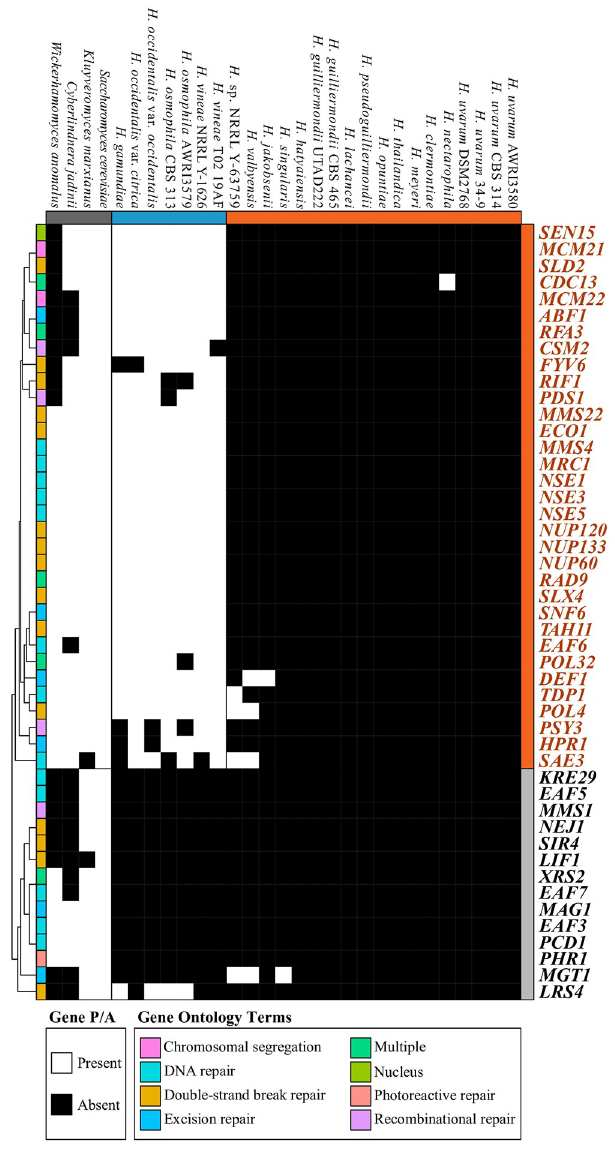
Fig 4. A panoply of genome-maintenance and DNA repair genes are absent among Hanseniaspora , especially in the FEL. Genes annotated as DNA repair genes according to GO (GO:0006281) and child terms were examined for presence and absence in at least two-thirds of each lineage, respectively (268 total genes). 47 genes are absent among the FEL species, and 14 genes are absent among the SEL. Presence and absence of genes was clustered using hierarchical clustering (cladogram on the left) where each gene’s ontology is provided as well. Genes with multiple gene annotations are denoted as such using the “multiple” term. figshare: https://doi.org/10.6084/m9.figshare.7670756. v2. ABF1 , Autonomously replicating sequence-Binding Factor 1; AWRI, Australian Wine Research Institute; CBS, Centraalbureau voor Schimmelcultures; CDC13 , Cell Division Cycle 13; CSM2 , Chromosome Segregation in Meiosis 2; DEF1 , RNA polymerase II Degradation Factor 1; DSM2768, Dutch State Mines 2768; EAF6 , Essential something about silencing 2-related acetyltransferase 1-Associated Factor 6; ECO1 , Establishment of Cohesion 1; FEL, faster- evolving lineage; FYV6 , Function required for Yeast Viability 6; GO, gene ontology; HPR1 , HyPerRecombination 1; KRE29 , Killer toxin Resistant 29; LIF1 , Ligase Interacting Factor 1; LRS4 , Loss of RDNA Silencing 4; MAG1 , 3-MethylAdenine DNA Glycosylase 1; MCM21 , Mini-Chromosome Maintenance 21; MGT1 , O-6-MethylGuanine- DNA methylTransferase 1; MMS22 , Methyl MethaneSulfonate sensitivity 22; MRC1 , Mediator of the Replication Checkpoint 1; NEJ1 , Nonhomologous End-Joining defective 1; NRRL, Northern Regional Research Laboratory; NSE1 , NonStructural maintenance of chromosomes Element 1; NUP120 , NUclear Pore 120; PCD1 , Peroxisomal Coenzyme A Diphosphatase 1; PDS1 , Precocious Dissociation of Sisters 1; PHR1 , PHotoreactivation Repair deficient 1; POL32 , POLymerase 32; PSY3 , Platinum SensitivitY 3; P/A, presence or absence; RAD9 , RADiation sensitive 9; RFA3